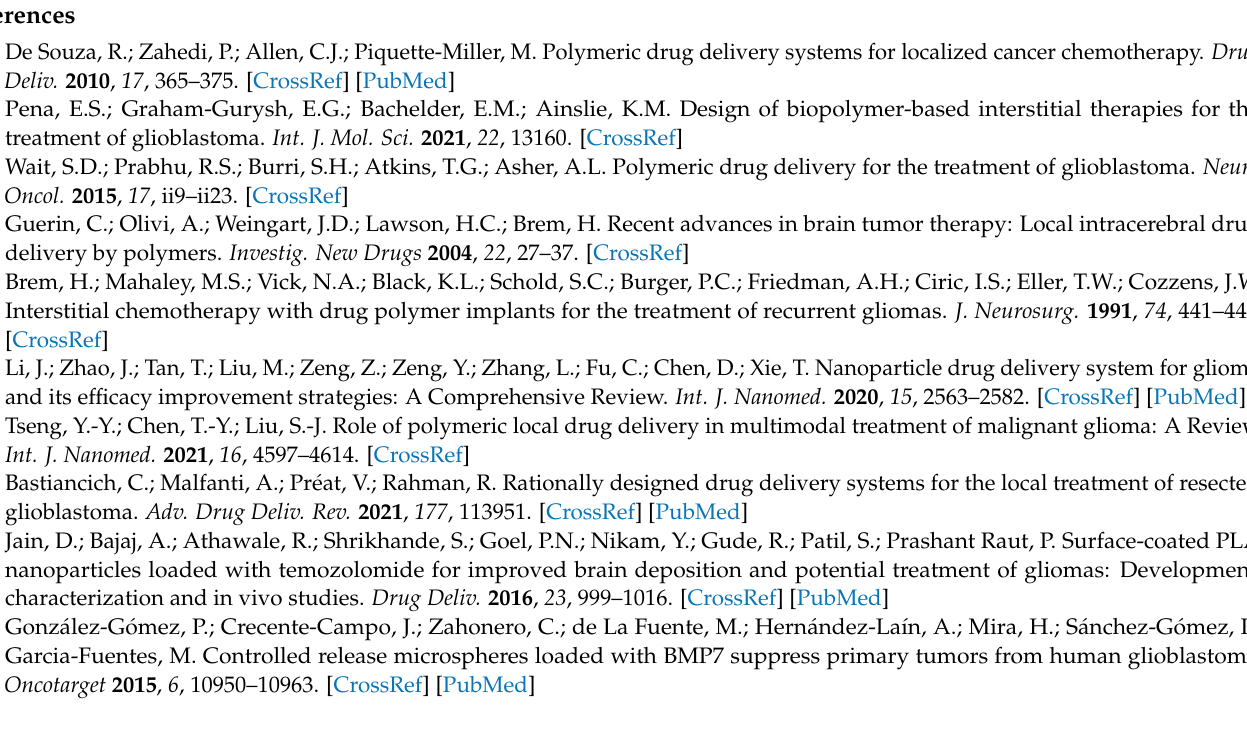
based drug delivery system; Figure S2: Loading of reservoir-based drug delivery system; Figure S3: Synchrotron radiation-based µ CT analysis of PDMS templates; Figure S4: Mesh reproducibility; Figure S5: Release curves; Table S1: Quantitative PDMS microchannel network